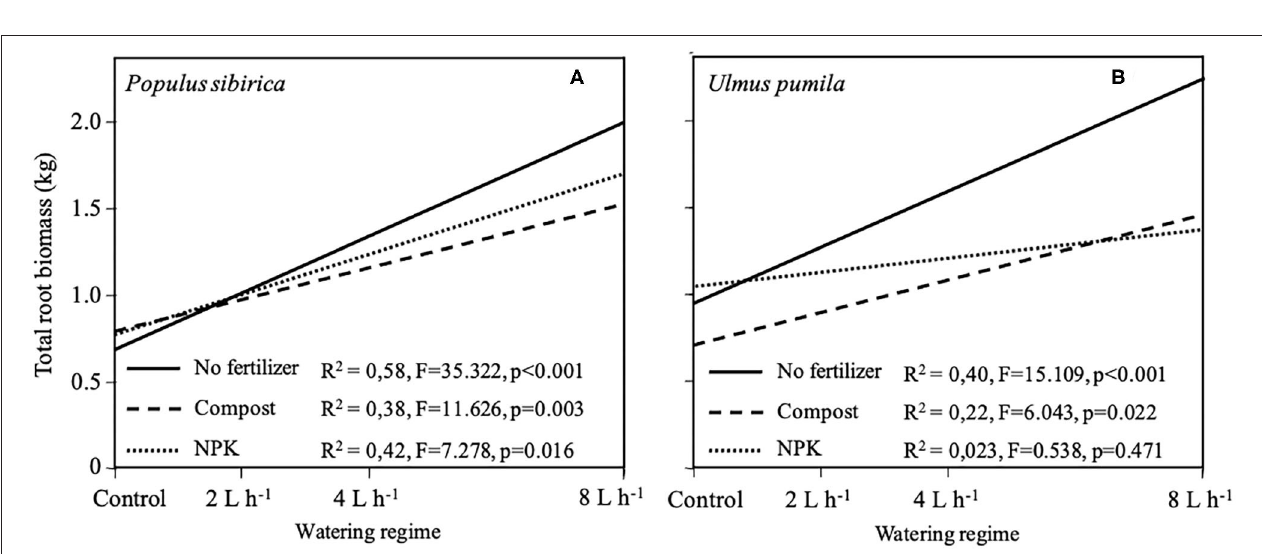
FIGURE 7 | Regression models of total root biomass for P. sibirica (A) and U. pumila (B) calculated by destructive sampling in relation with different watering regimes and fertilization treatment (No fertilizers, solid line; Compost, dashed line; NPK, dotted line).